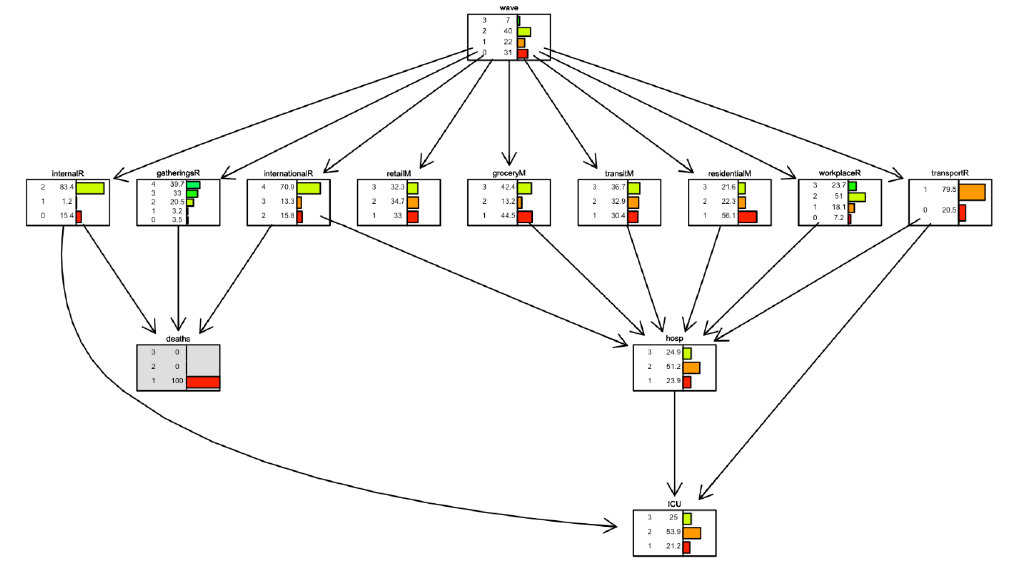
Figure 22. Scenario for Israel when daily deaths are less than 5 (level 1). Deaths node is highlighted in